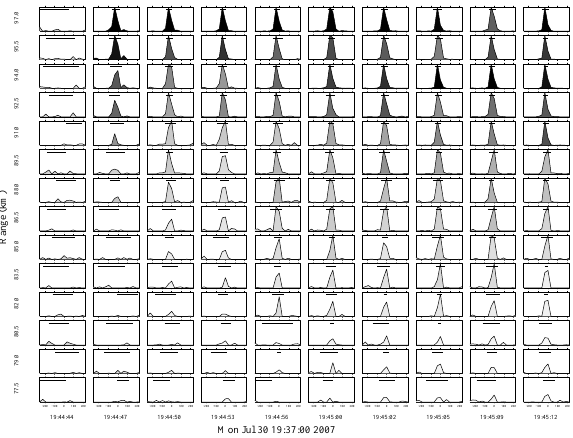
Fig. 5. Doppler spectra computed during the early part of a heating event. The gray levels represent relative signal intensity on a per column basis.